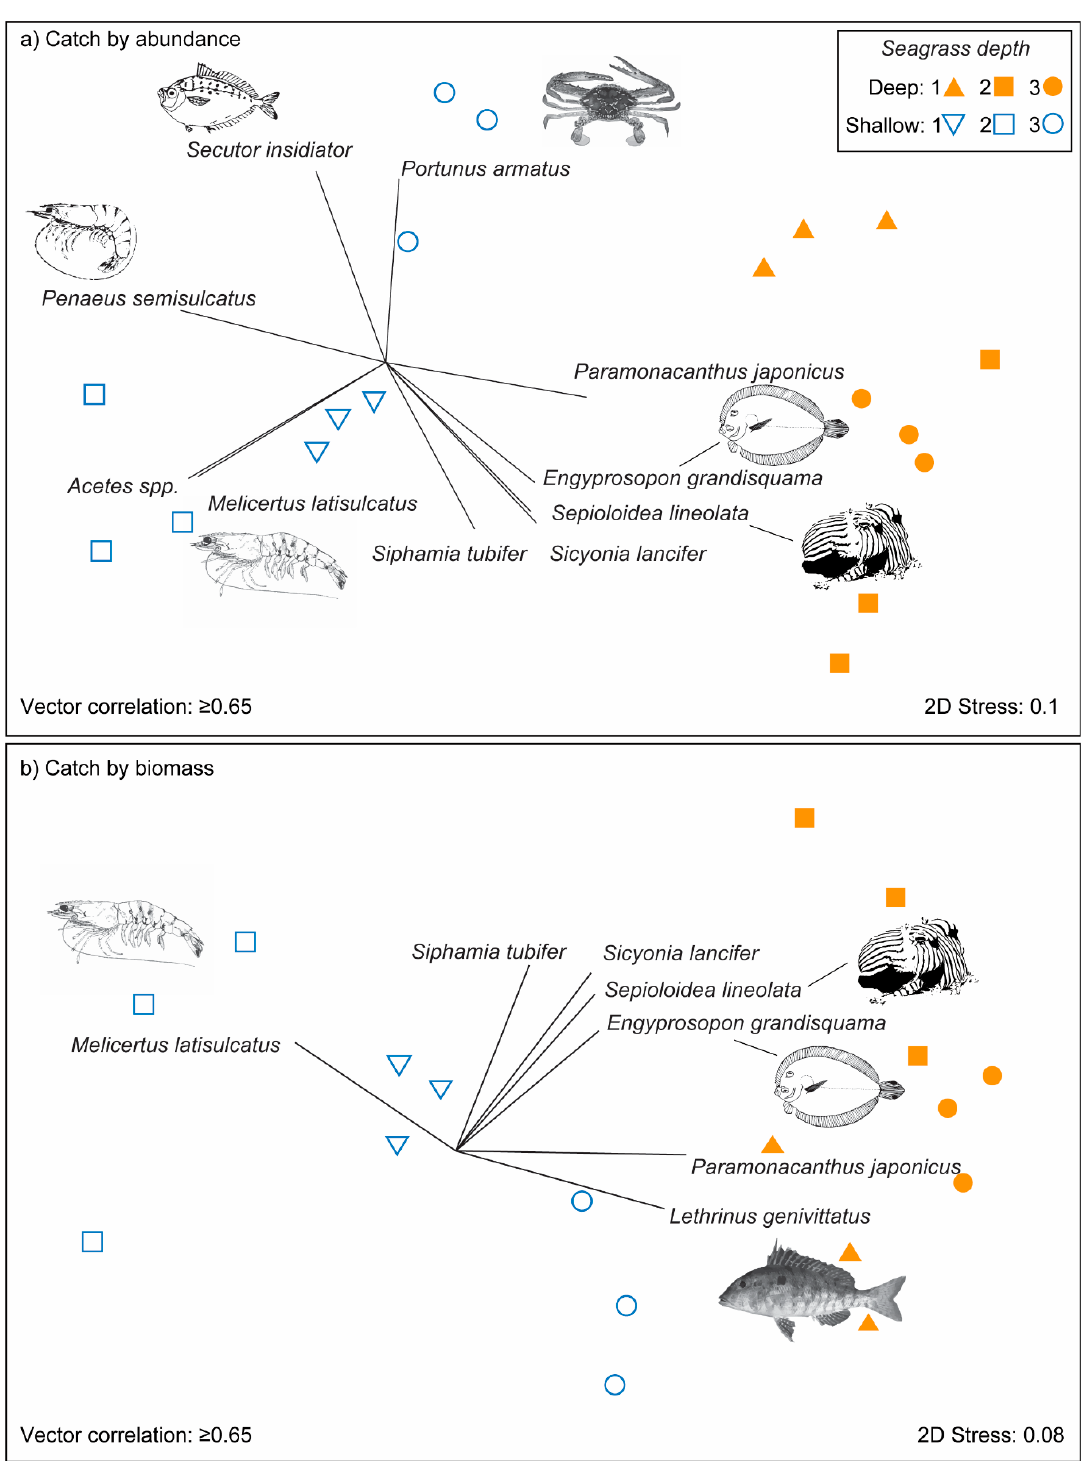
Figure 3. Non-metric multidimensional scaling showing differences in nekton assemblage structure of deep and shallow seagrass meadows in ( a ) catch per unit effort (CPUE) and ( b ) biomass per unit effort (BPUE), based on trawl haul data (points). Vectors represent partial regression coefficients of the original variables within 2 dimensions. Vector length is proportional to strength of correlation. Table 1. Details of percentage similarity (SIMPER) analyses for Group depth (Deep vs. Shallow) identified as being significantly different. Fish species by catch per unit effort (CPUE) and biomass per unit effort (BPUE), which contribute to the similarity within and dissimilarity among each group, are given. Similarity (SIM/SD) or dissimilarity (DISS/SD) ≥ 2 indicates consistency of a species contribution amongst samples (trawls); Contrib. % is the percent contribution of a species to the